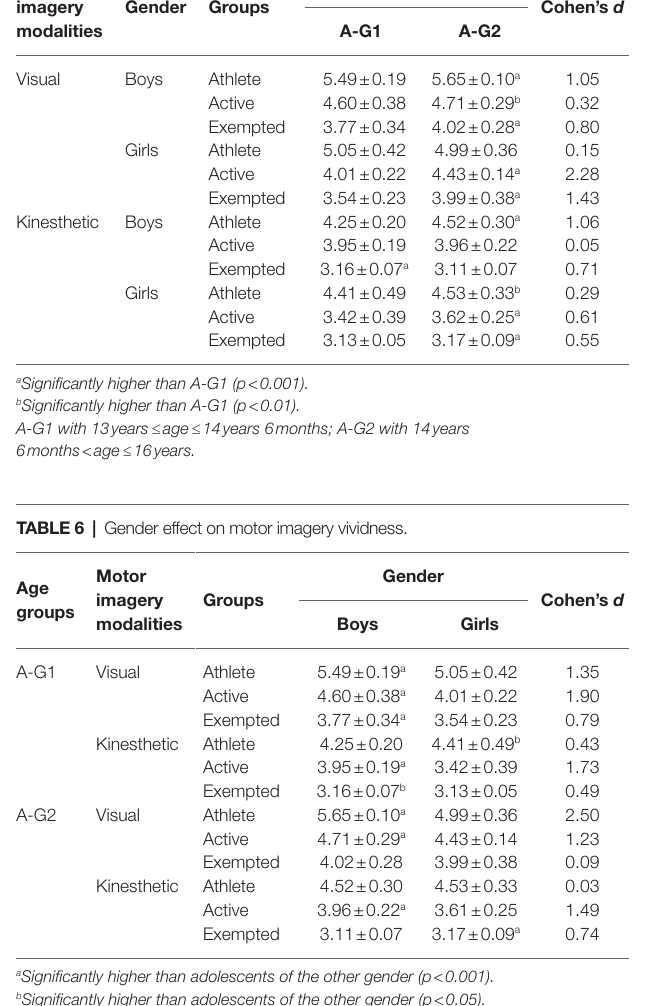
TABLE 5 | Age effect on motor imagery vividness. Motor imagery